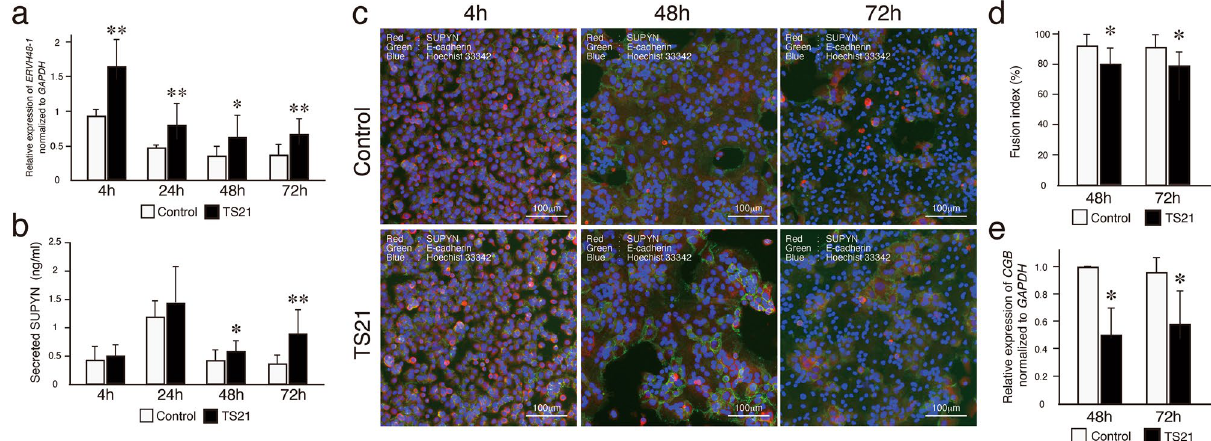
Figure 4. Expression of SUPYN and cell fusion indices in primary, spontaneously syncytializing human cytotrophoblast cells derived from TS21 and normal gestational age-matched control placentas. ( a ) ERVH48-1 transcription in primary trophoblast cells was quantitated using RT-PCR. Fold-induction ratio of ERVH48-1 transcripts in TS21 were compared with gestation matched control placenta at 4 h. ( b ) Detection of SUPYN protein in primary trophoblast cell culture supernatants by a SUPYN-specific ELISA (ng/ml). Experiments were performed in duplicate using 3 independent placental samples. Statistical analysis was performed using the Mann Whitney U test. Statistical significance was set at * : p < 0.05, ** : p < 0.01. Values represent mean ± SD (n = 3). ( c ) Time course of SUPYN protein expression in cultured primary, syncytializing cytotrophoblast cells from TS21 and gestational age-matched control placentas. Immunofluorescence images were obtained at 4 h, 48 h and 72 h after plating [SUPYN (red), E-cadherin (green) and Hoechst 33342 (blue)]. Upper panels